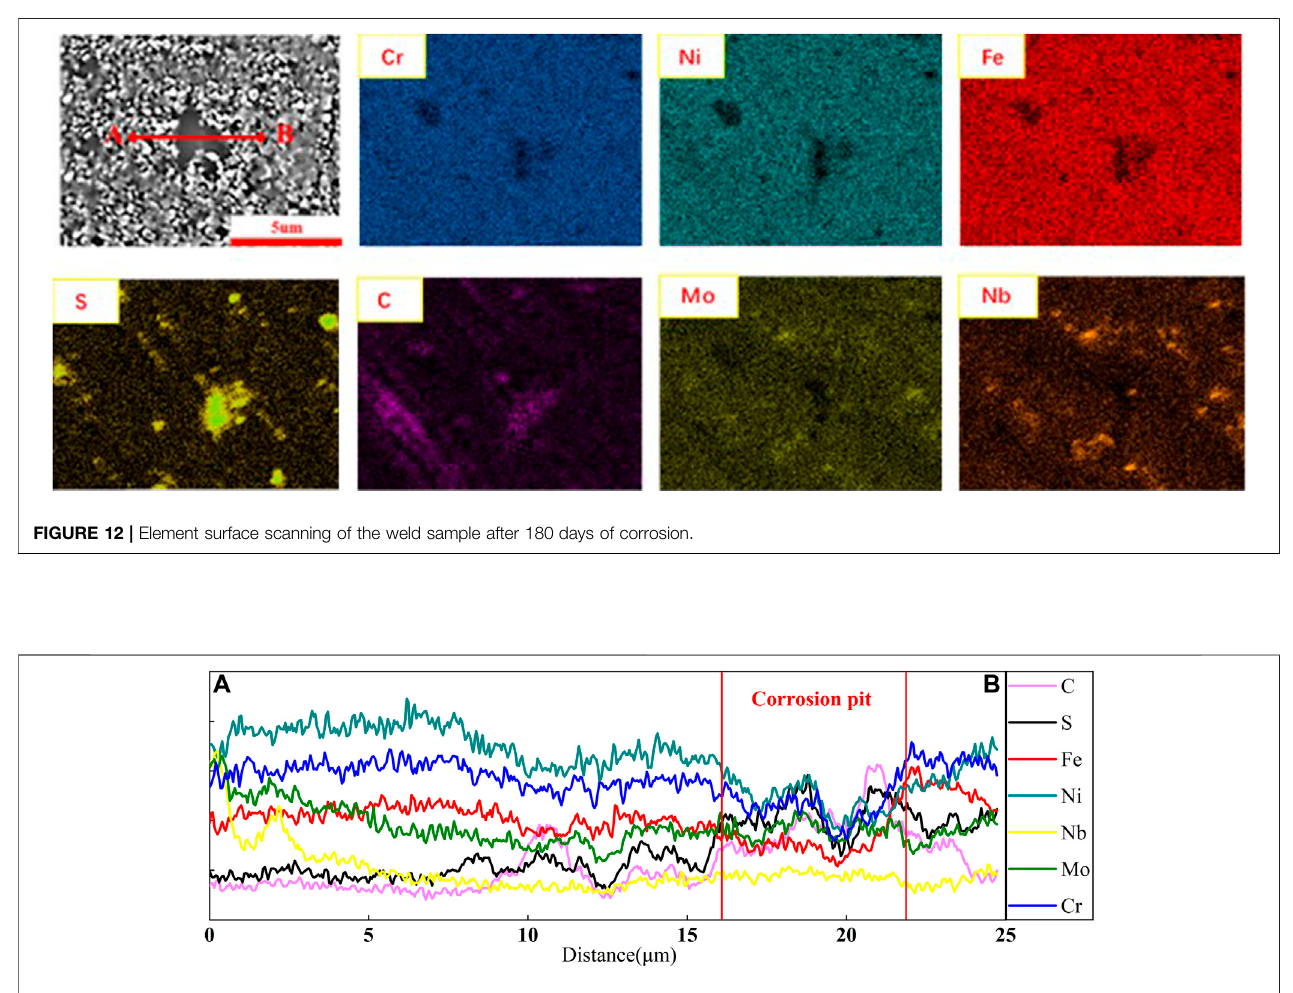
FIGURE 13 | Element line scan of the weld sample after 180 days of corrosion.